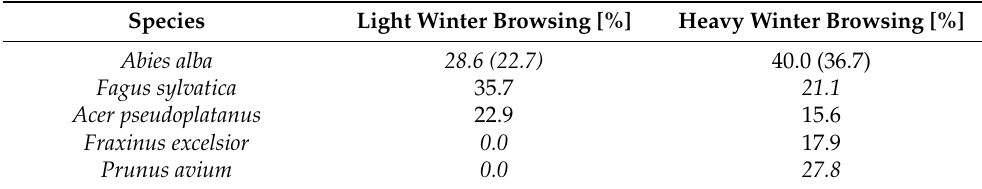
Figure 5. Relative growth rate in 2021 (RGR2021) of the corresponding species divided by the RGR2021 of Fagus sylvatica per height class and plot, i.e., only saplings of similar height were compared. The red line indicates equal growth of both species. For details about the box plot, see Figure 4. For better readability, some outliers have been omitted (e.g., A. alba 2 no, A. pseudoplatanus 4 no and 2 light, F. excelsior 3 no and 1 light, P. avium 3 no), but they are included in the numbers. After browsing during the vegetation period, only 10% of F. sylvatica, but at least 40% of A. pseudoplatanus , 50% of P. avium and 67% of F. excelsior saplings responded to light browsing with the formation of a new shoot within the same vegetation period. Table 3. Percentage of tree saplings with no leader shoot in 2022 after light or heavy winter browsing in 2021/2022 for the six main tree species of height class (HC) 1 to HC4 ( Picea abies excluded, due to too few browsed saplings). Values in italics are based on only 14–24 saplings. Values in brackets include the HC0 saplings of Abies alba